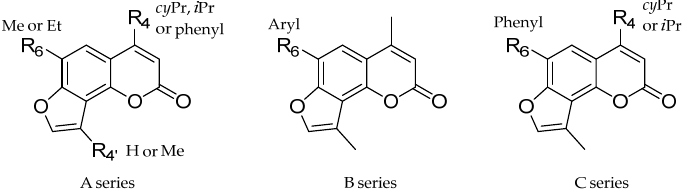
Figure 3. Series of TMA analogs.